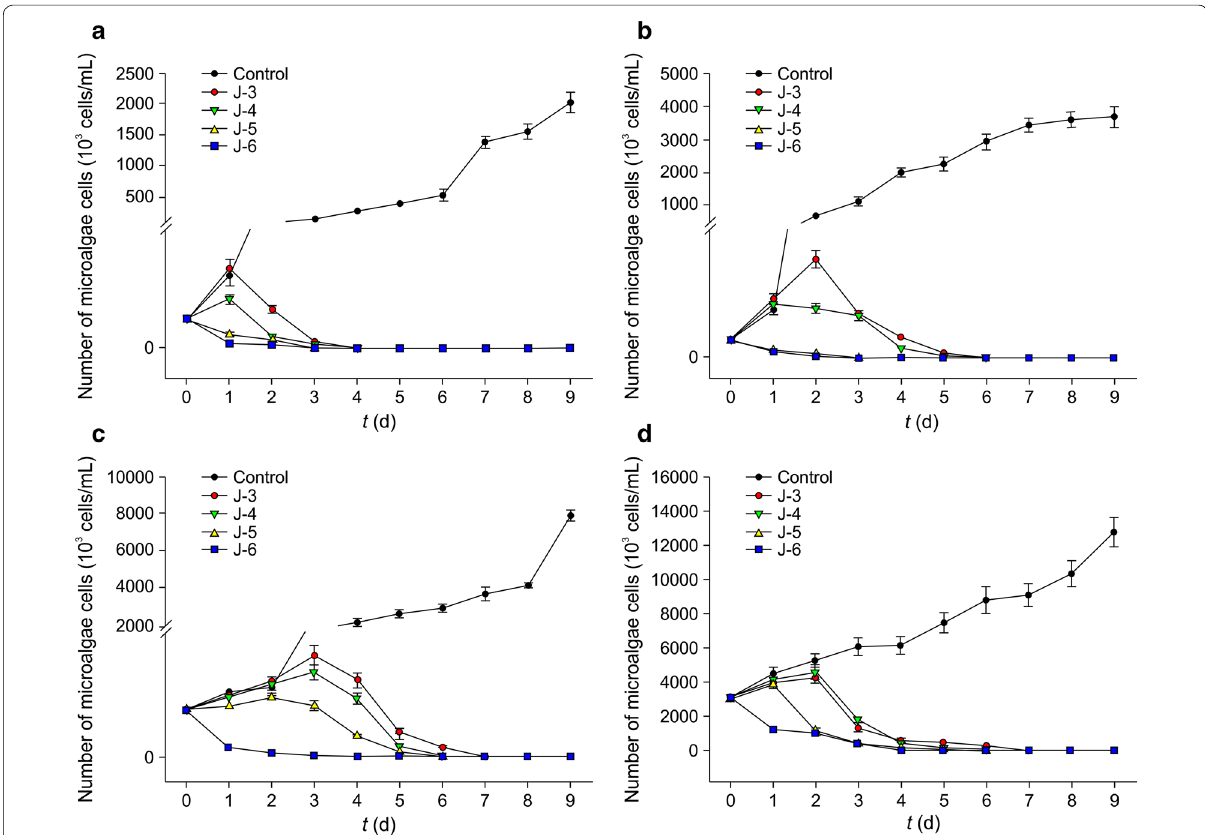
Fig. 8 Alginolytic effects of different initial concentrations of CZBC1 on Oscillatoria tenuis at different initial concentrations. a 10 3 cells/mL. b 10 4 cells/mL. c 10 5 cells/mL. d 10 6